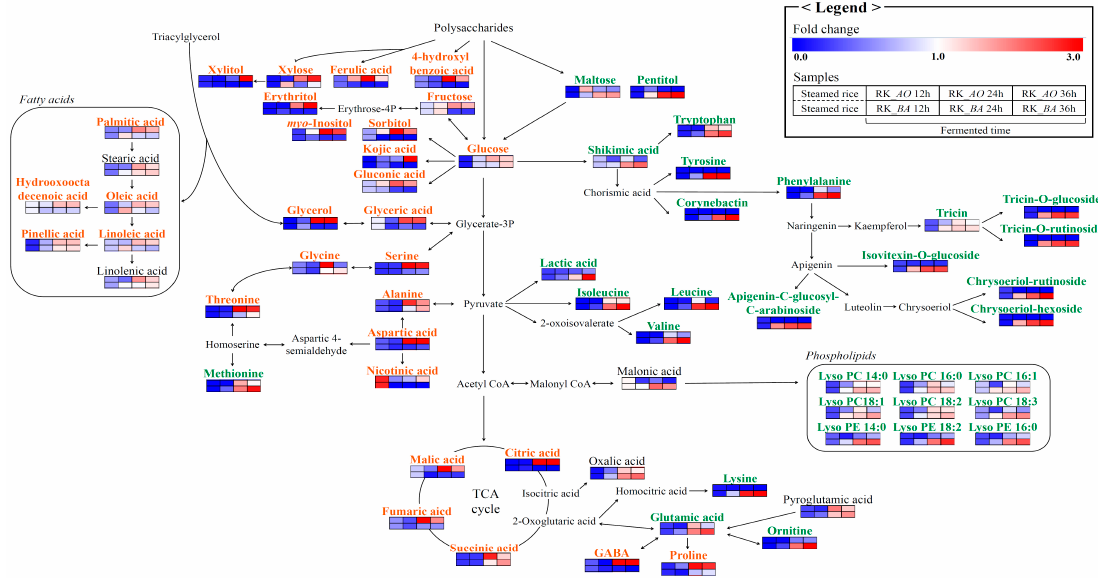
Figure 3. Scheme of the metabolic pathway and relative metabolite contents in rice koji fermented with A. oryzae (RK_ AO ) or B. amyloliquefaciens (RK_ BA ). The pathway was retrieved from the KEGG database and modified (KEGG. http://www.genome.jp/kegg). The colored squares (blue-to-red) represent fold changes normalized by the average of all values for each metabolite. The orange characterized metabolites had significantly higher relative contents in RK_ AO , while the green characterized metabolites had higher contents in RK_ BA (VIP > 1.0 and p < 0.05 in